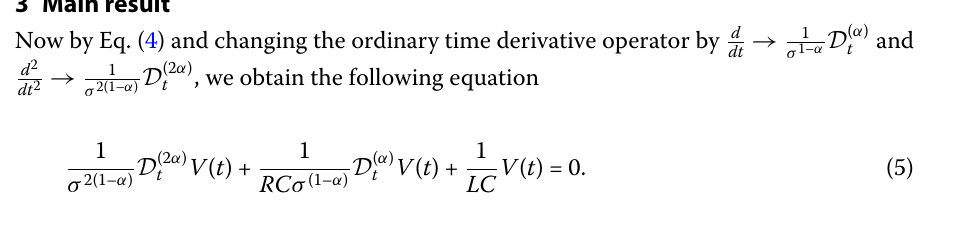
Note that its solution is a natural response of the circuit which we need. For solving Eq. (4) with normal derivative, we consider three cases. In this way, put a = 1 Note that, for avoiding computations in numerical examples, non-laboratory inductor and capacitor values have been selected by researchers